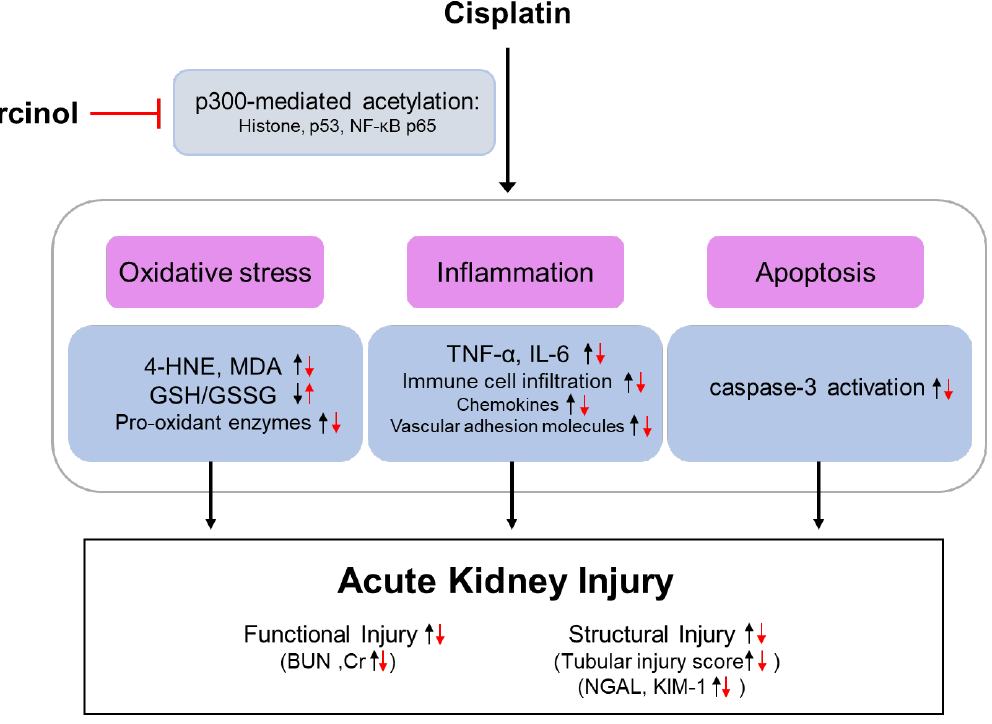
Figure 6. Schematic summary of key findings of the present study. Inhibition of p300 by garcinol attenuated cisplatin-induced functional and structural renal injury through suppressing oxidative stress, inflammation, and apoptosis. These effects were associated with a reduction in acetylation of NF-κB p65 and p53 as well as histone acetylation.